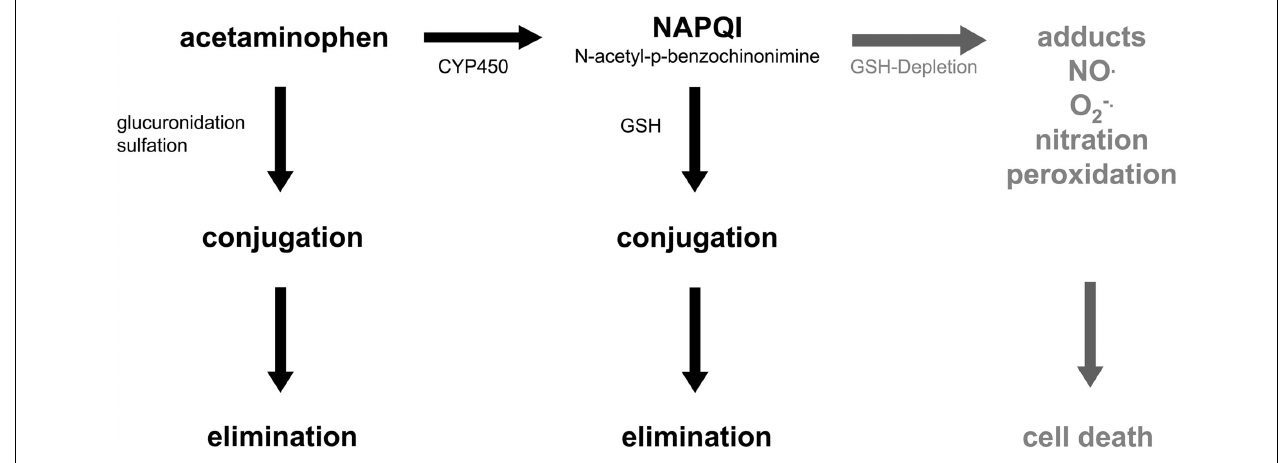
(GSH). Depletion of GSH leads to formation of reactive nitrogen and oxygen species, which in turn causes cell death. For further details see text.